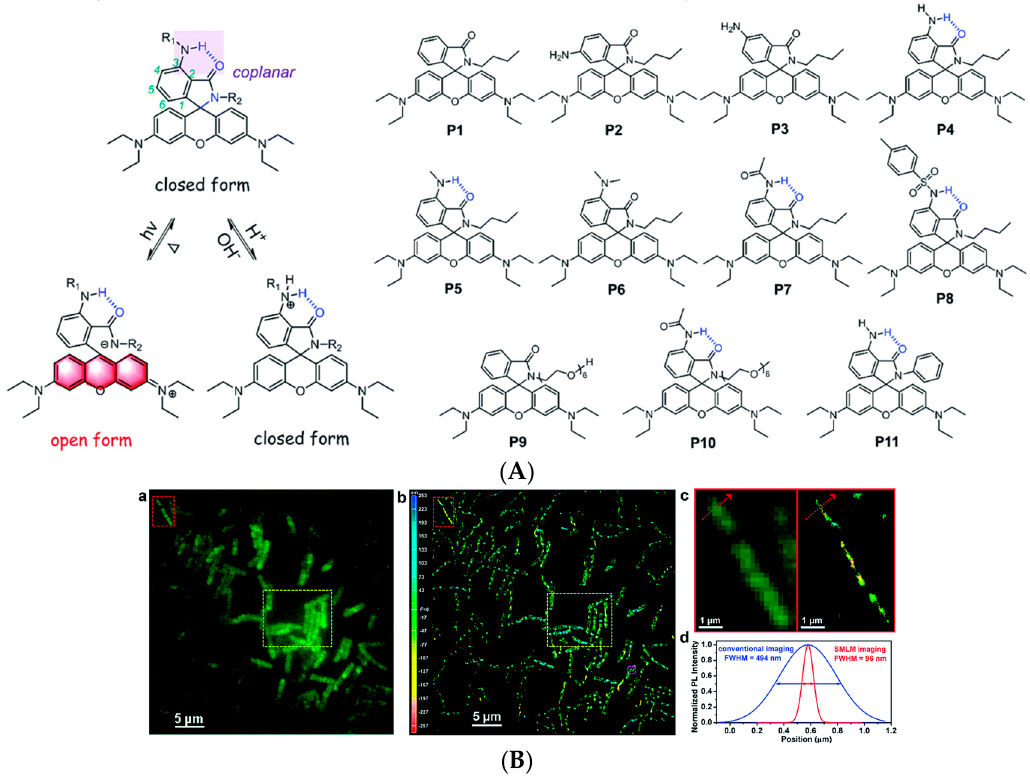
Figure 21. Photo-switchable, acid tolerant spirolactams: ( A ) Intramolecular hydrogen bonding enables acid-resistant photo-switchable rhodamine spirolactams and chemical structures of P1–P11 ; ( B ) ( a ) Conventional diffraction-limited fluorescence image and ( b ) 3D-SMLM image of live Bacillus subtilis cells stained with their final probe. ( c ) Comparison of the imaging resolution of the three adjacent Bacillus subtilis cells in the enlarged region, as highlighted by red rectangles. ( d ) Gaussian fittings to the normalized PL intensities across a randomly selected bacterium (cross-sectional analysis along the red arrow). Adapted with permission from [266]—Published by the Royal Society of Chemistry.